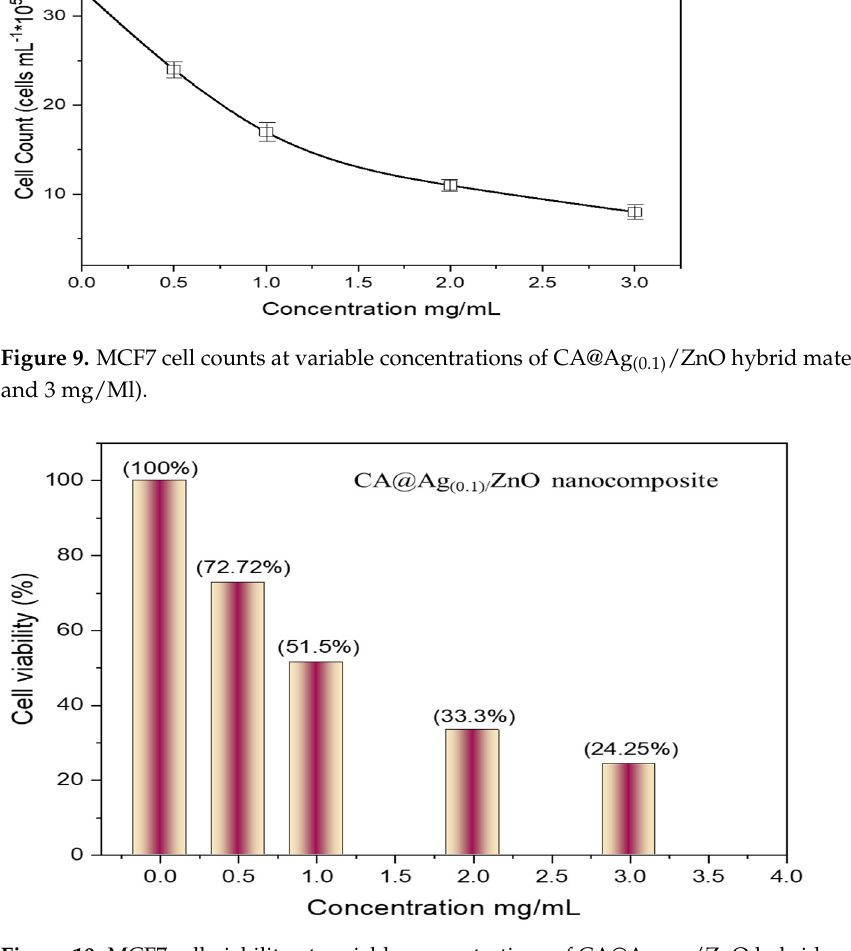
Figure 10. MCF7 cell viability at variable concentrations of CA@Ag (0.1) /ZnO hybrid material (0.50, 1, 2, and 3 mg/mL).